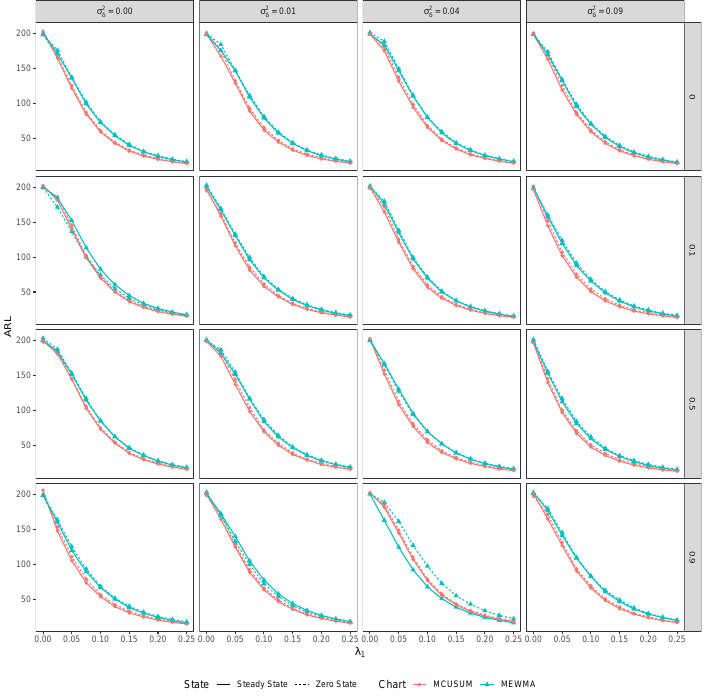
Figure 2. Zero-state and steady-state ARL for MCUSUM and MEWMA under shift in